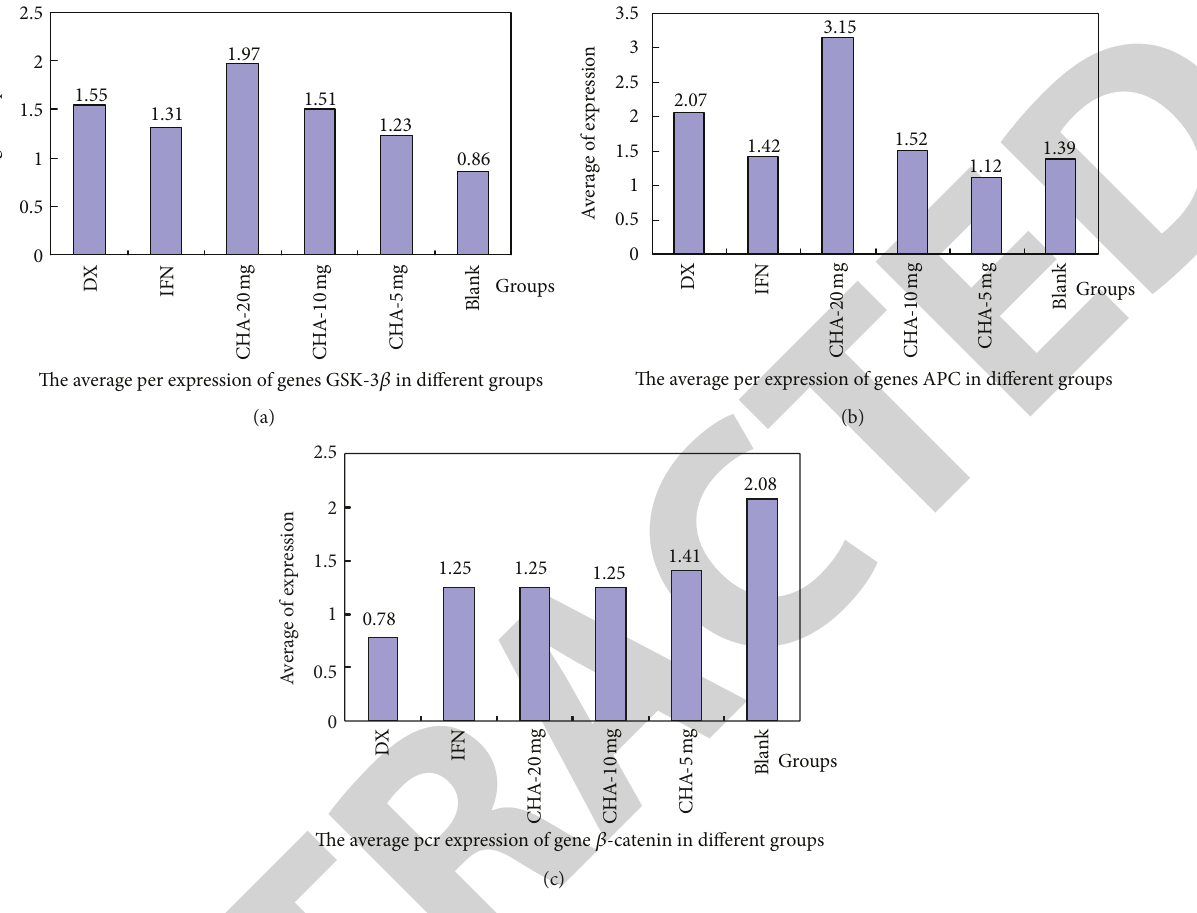
Figure 6: The average PCR expression of different genes in different groups. (a) GSK-3 𝛽 , (b) gene APC, and (c) gene 𝛽 -catenin.